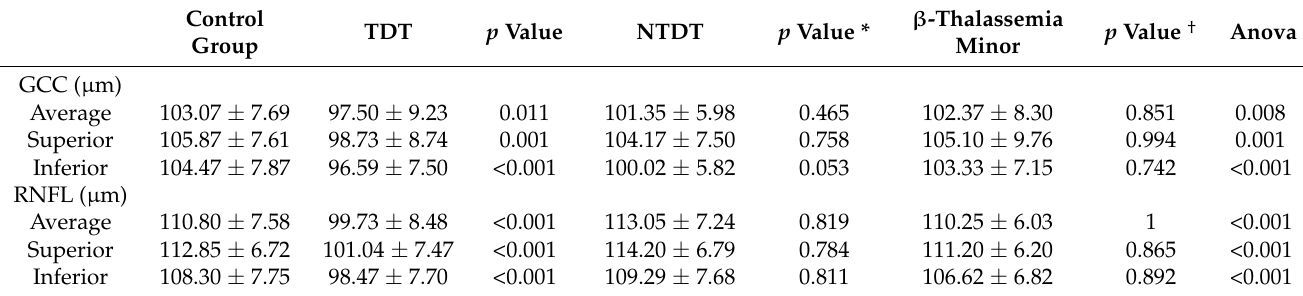
Table 2. Differences in SD-OCT parameters among the controls and β -thalassemia patients.